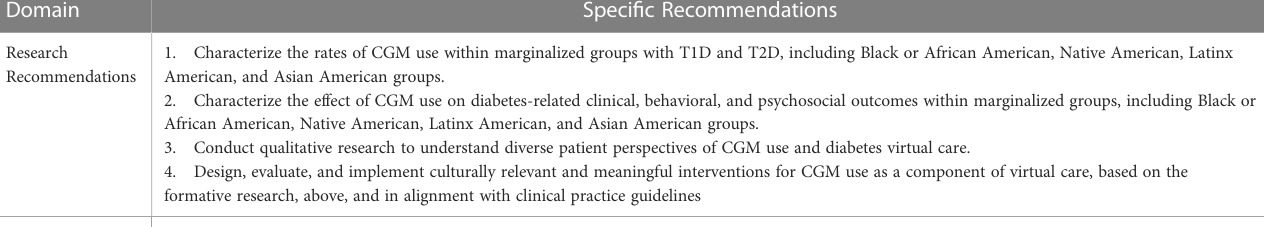
TABLE 3 Research and clinical recommendations for CGM use in marginalized populations as a component of diabetes virtual care.